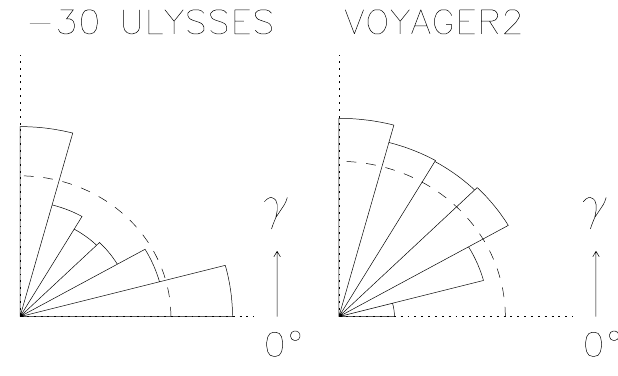
Fig. 16. Distribution of the angle γ between n and the mean mag- netic field in the layer for Ulysses II (for the inner heliosphere) and Voyager 2 (middle heliosphere); the dashed circle indicates a uni- form